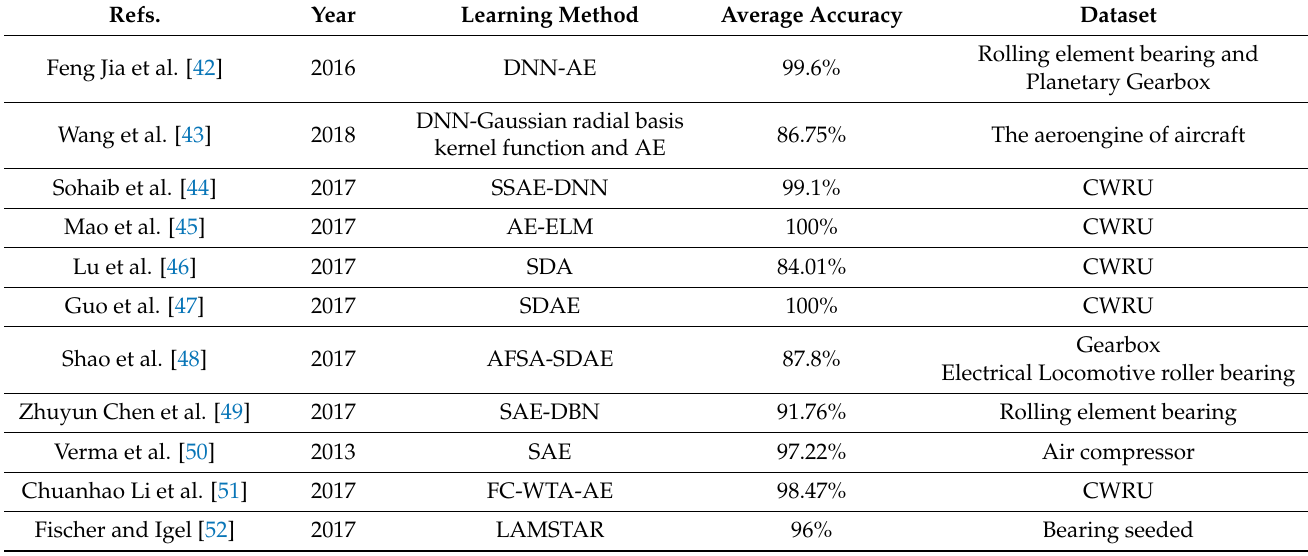
Table 5. Auto-encoder methods used for fault bearing diagnosis research comparison.